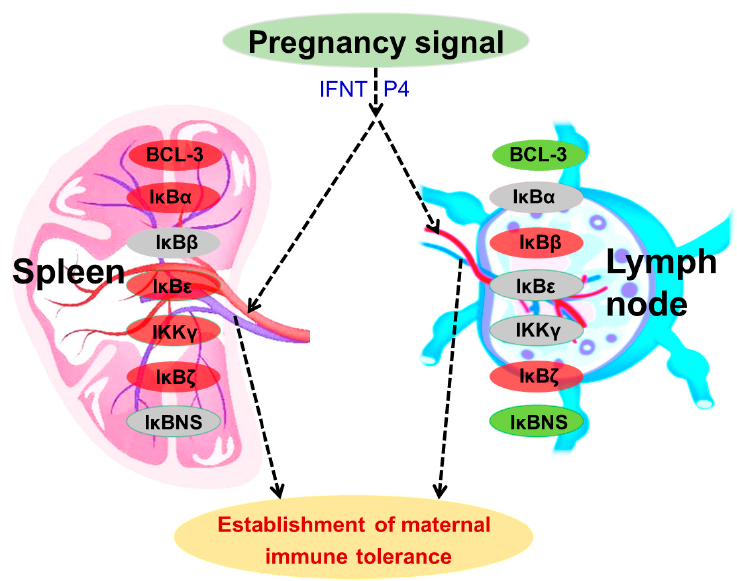
Figure 7. Proposed sketch of I κ B family in maternal spleen and lymph nodes during early pregnancy in sheep. Early pregnancy signals, including interferon-tau (IFNT) and progesterone (P4), induce changed expression of I κ B family, including B cell leukemia-3 (BCL-3), I κ B α , I κ B β , I κ B ε , IKK γ , I κ B ζ and I κ BNS, in a tissue-specific manner, which contributes to establishment of maternal immune tolerance during early pregnancy. Note: red, stimulators; green, negative regulators; blue, changed.